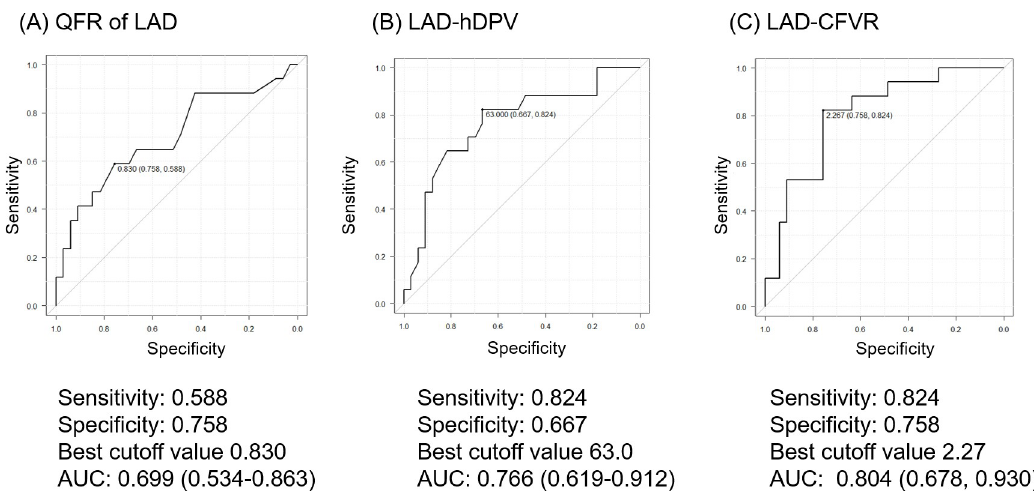
Fig 4. Diagnostic performance for improvement of LAD-CFVR. ROC curve analyses for (A) LAD-QFR, (B) pre-PCI LAD- hDPV, and (C) pre-PCI LAD-CFVR with the improvement of LAD-CFVR. Abbreviations as in Fig 1.